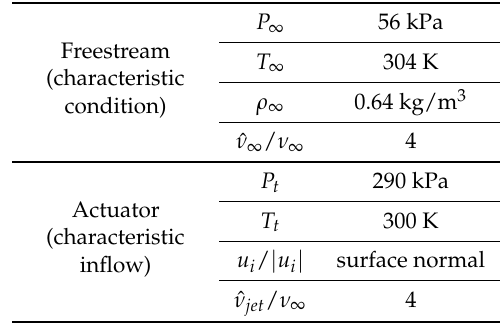
Table 1. Boundary conditions in the current simulation.